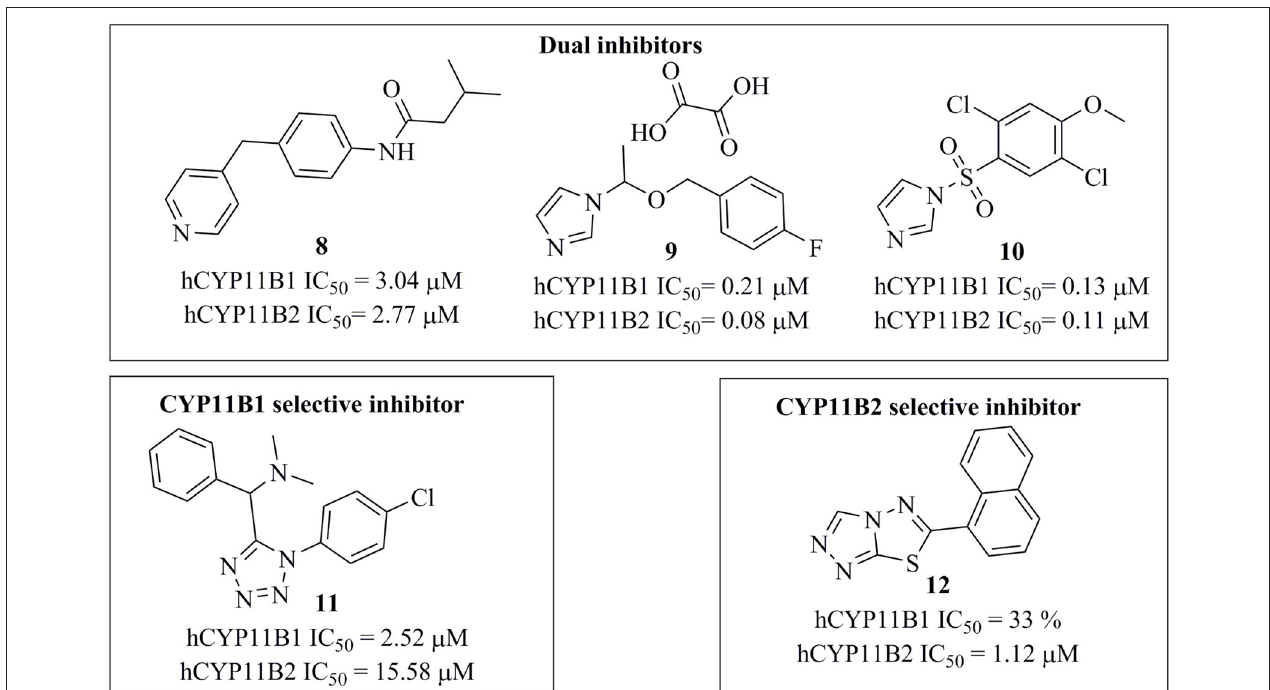
FIGURE 5 | Structures of the compounds 8–12 along with their IC 50 values determined in cell-based assays.